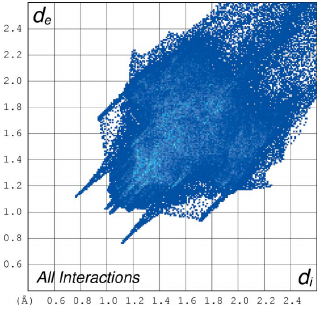
Figure 4 The two-dimensional fingerprint plot for the title compound depicting the overall contribution by the various contacts.